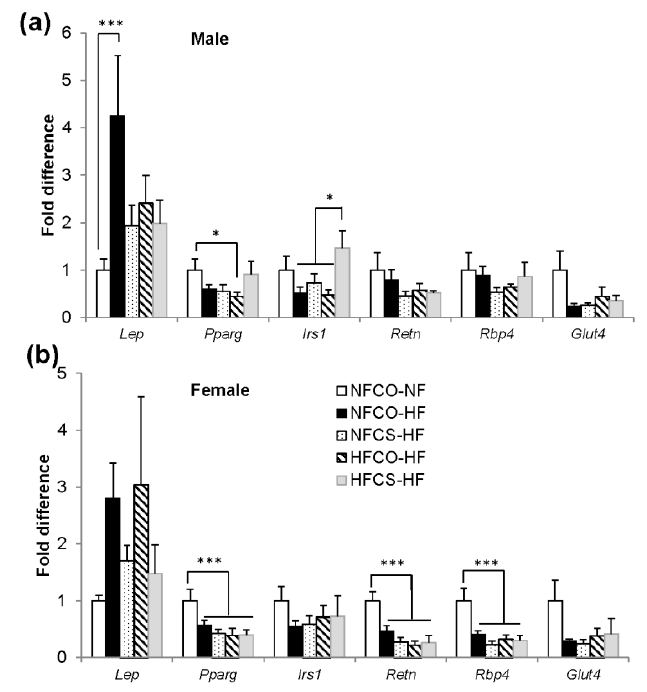
Figure 5. Visceral adipose tissue mRNA expression of mouse offspring after the 6-week post-weaning feeding in ( a ) male and ( b ) female offspring. n = 6 for the NFCO-NF group and n = 7 for the postnatal HF groups for each sex. Data were analyzed using the general linear model. Values represent means ± SEM. *, p < 0.05; ***, p < 0.001; CO, untreated control without choline; CS, choline supplemented; Glut4 , glucose transporter 4; HF, high fat; Irs1 , insulin receptor substrate 1; NF, normal fat; Pparg , peroxisome proliferator-activated receptor gamma; Rbp4 , retinol binding protein 4; Retn , resistin.